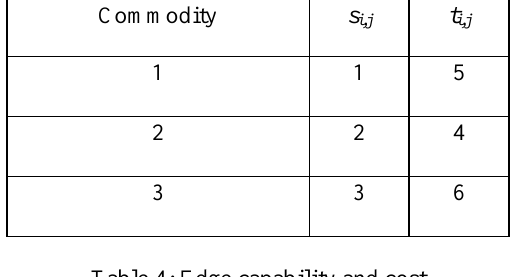
Table 4: Edge capability and cost